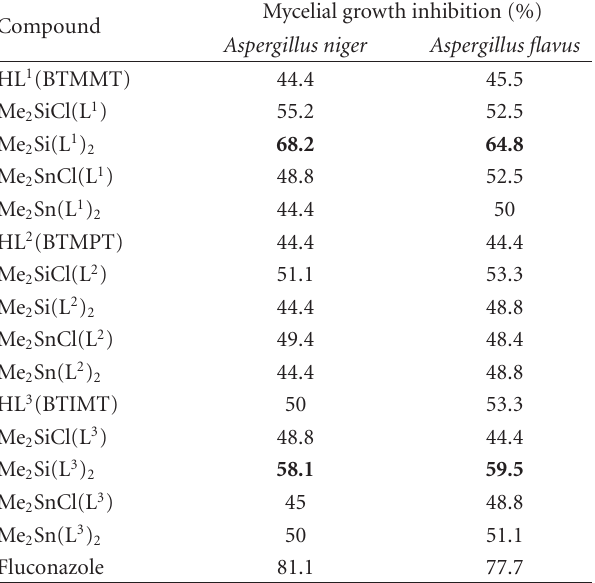
Table 5: In vitro antibacterial activity of the ligands and their metal complexes. Compounds